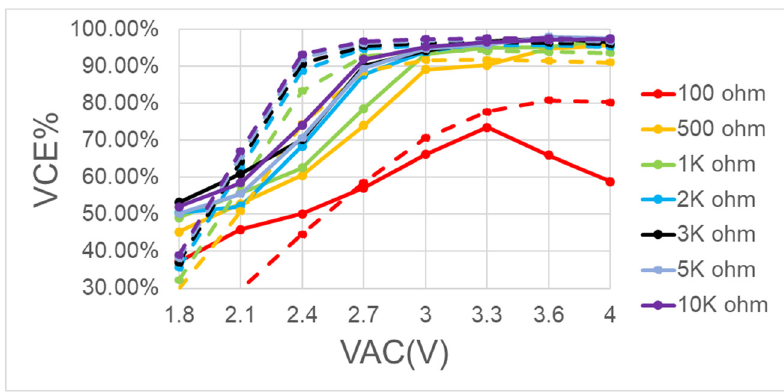
Figure 31. ( a ) simulation waveforms ( 𝑅 (cid:3013) = 100 Ω including input current); ( b ) Actual measurement board ( 𝑅 (cid:3013) = 100 Ω including input current).